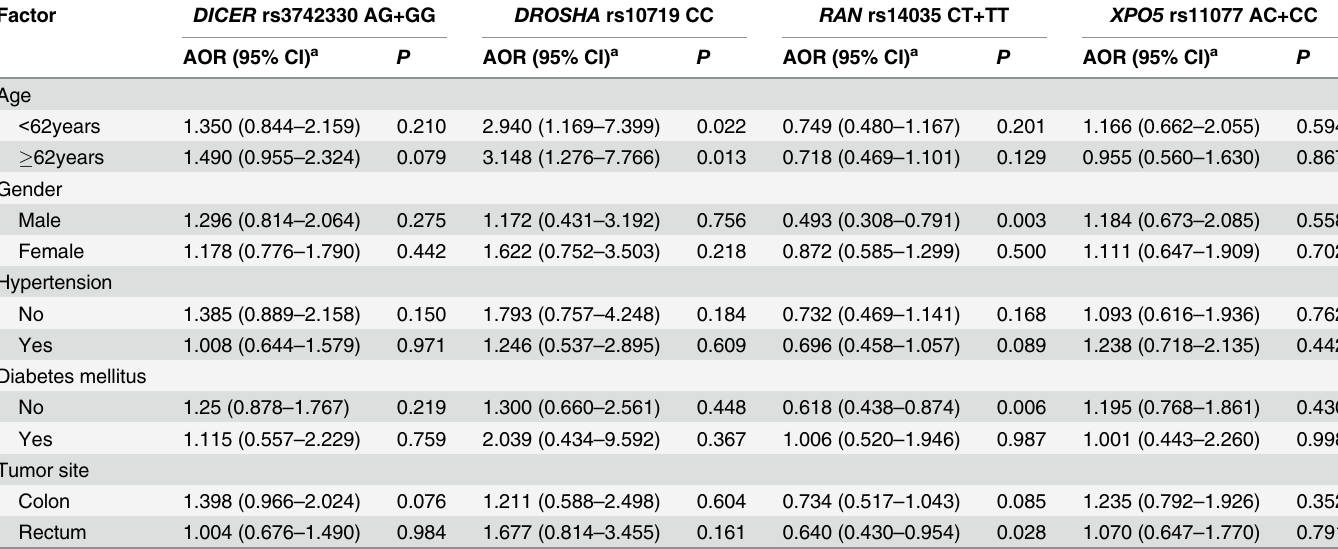
Table 6. Stratified effect of miRNA machinery gene polymorphisms on colorectal cancer risk (I). Factor DICER rs3742330